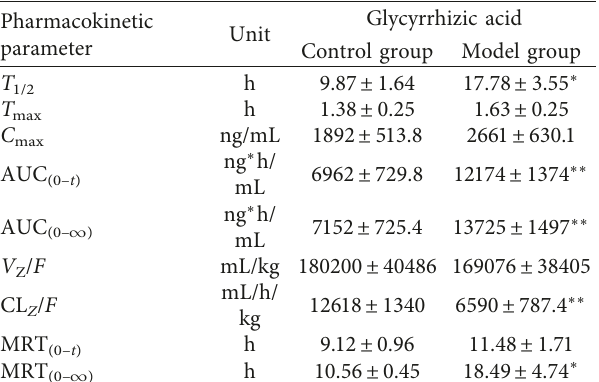
Table 7: The pharmacokinetic parameters of glycyrrhizic acid after HQD administration ( x ± SD, n �